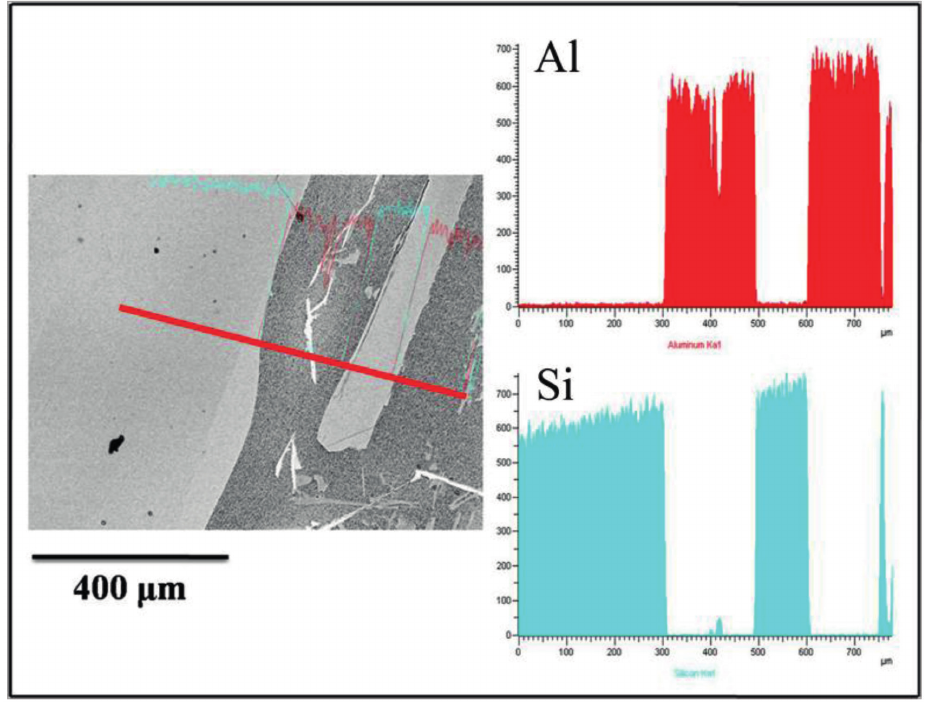
Fig. 10: SEM image of solidified 40% mass Si-Al alloy cooled at 0.81 mK/s and line scanning of